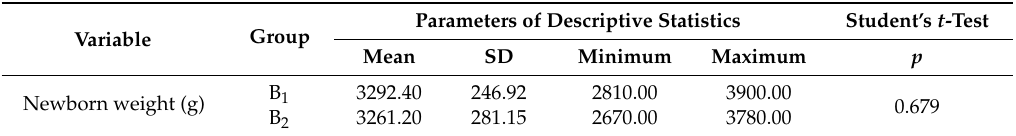
Table 5. Parameters of descriptive statistics and results of Student’s t -test for newborn weight in groups B 1 and B 2.